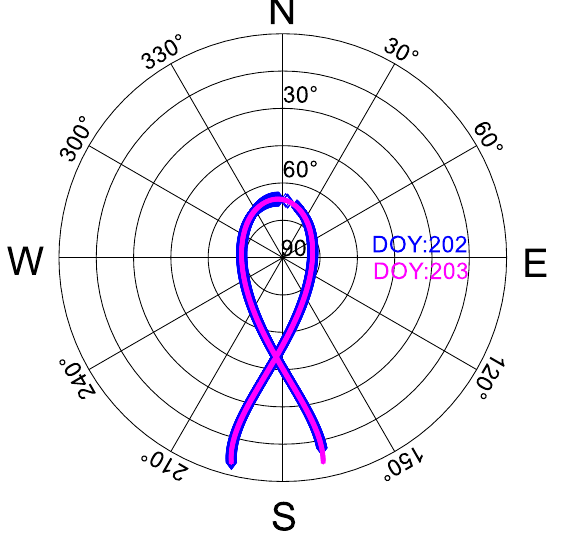
Figure 4. Skyplot of the GPS G32 satellite on DOY:200 (denoted by blue line) and DOY:201 (denoted by pink line), 2021. The vertical means the elevation angle, and the circle represents the azimuth angle.